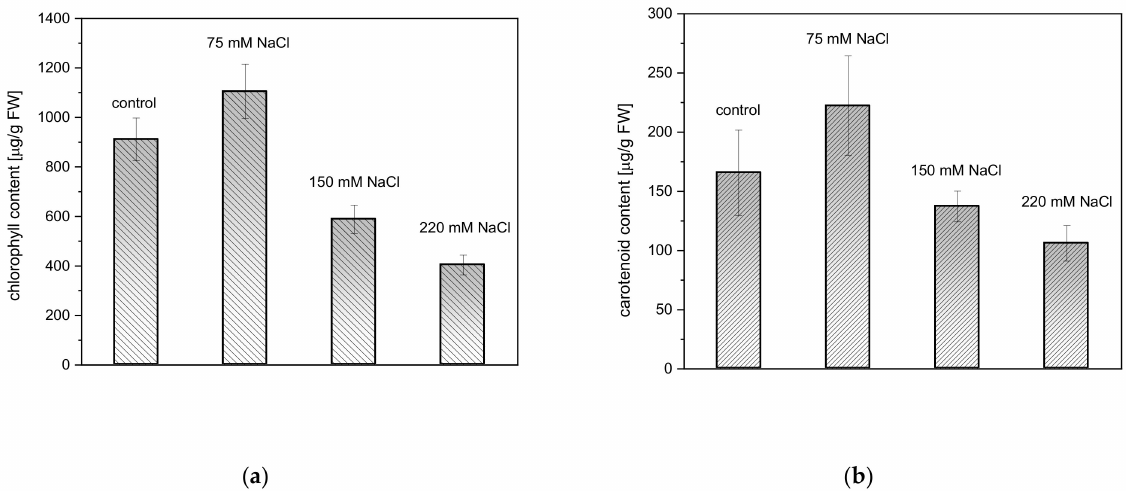
Figure 2. Total chlorophyll ( a ) and carotenoid ( b ) content in rosette leaves of four-week old A. thaliana plants, three days after exposure to salinity. Tests of statistical significance in Chl and Car content between the salt-treated plants compared to the controls were performed using ANOVA ( p ≤